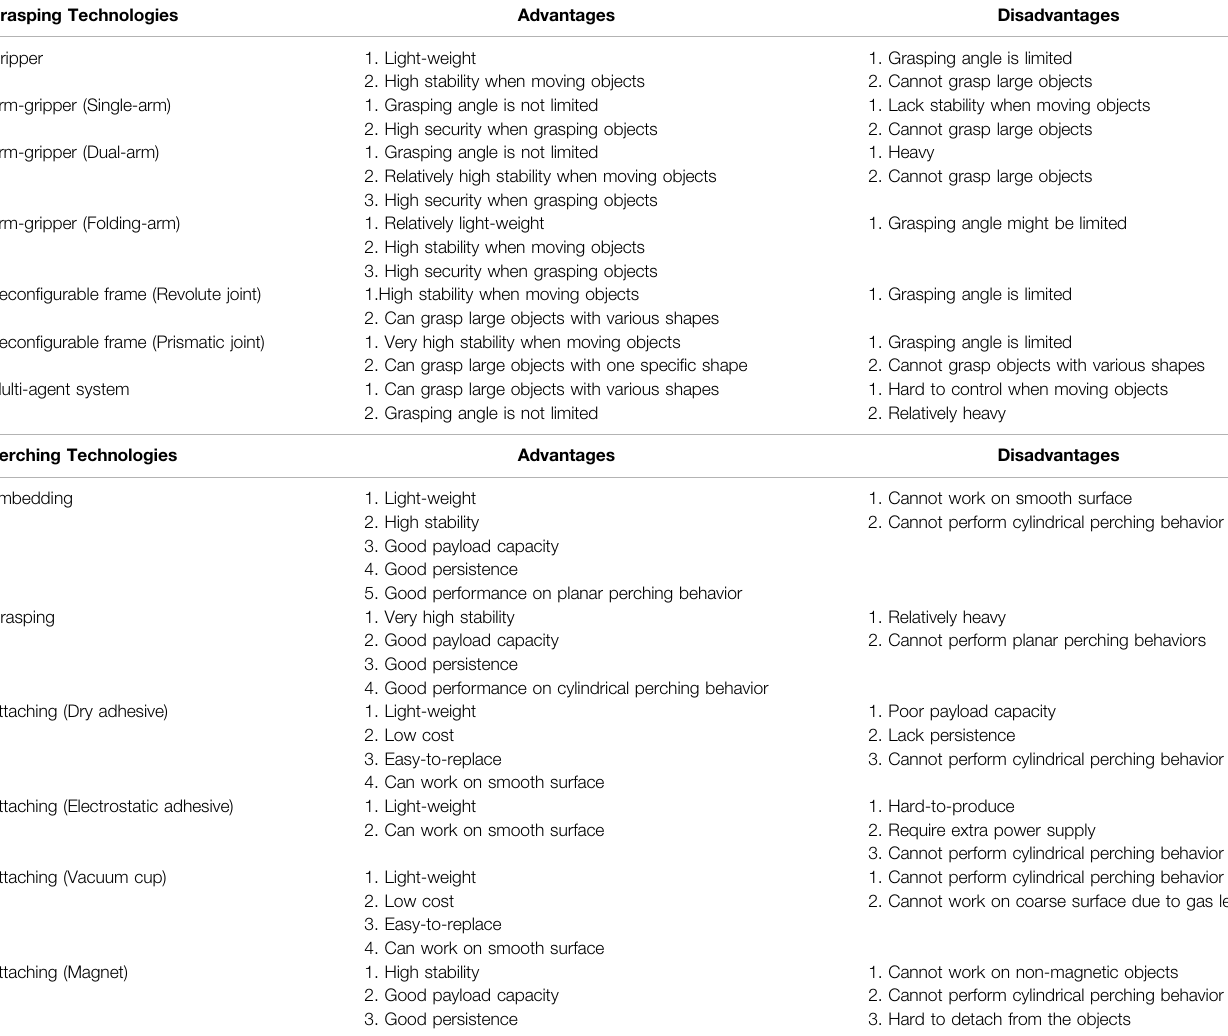
TABLE 5 | Advantages and disadvantages of the discussed aerial grasping and perching